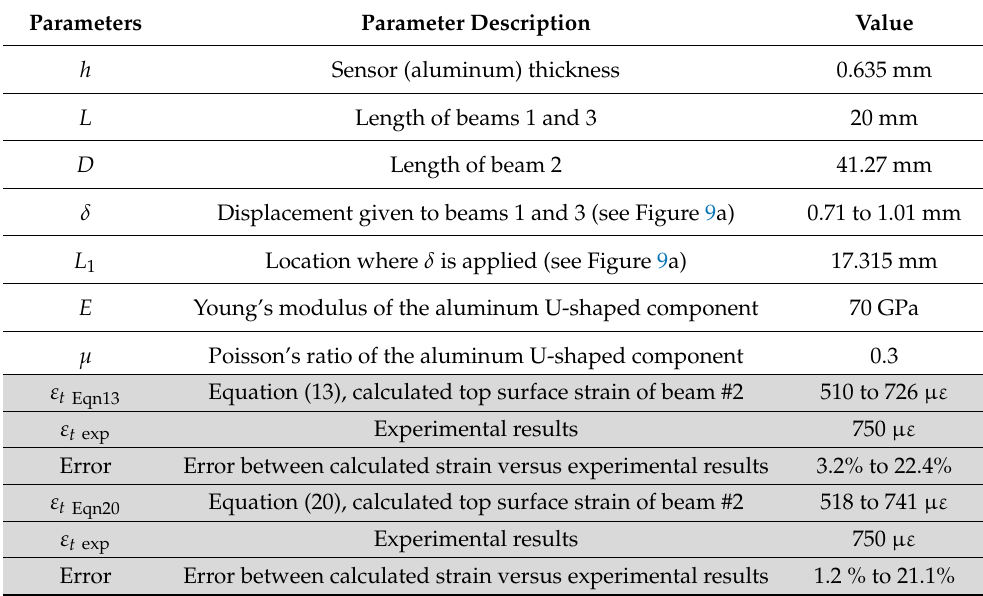
Table 2. Baseline parameters used to verify Equations (13) and (20).